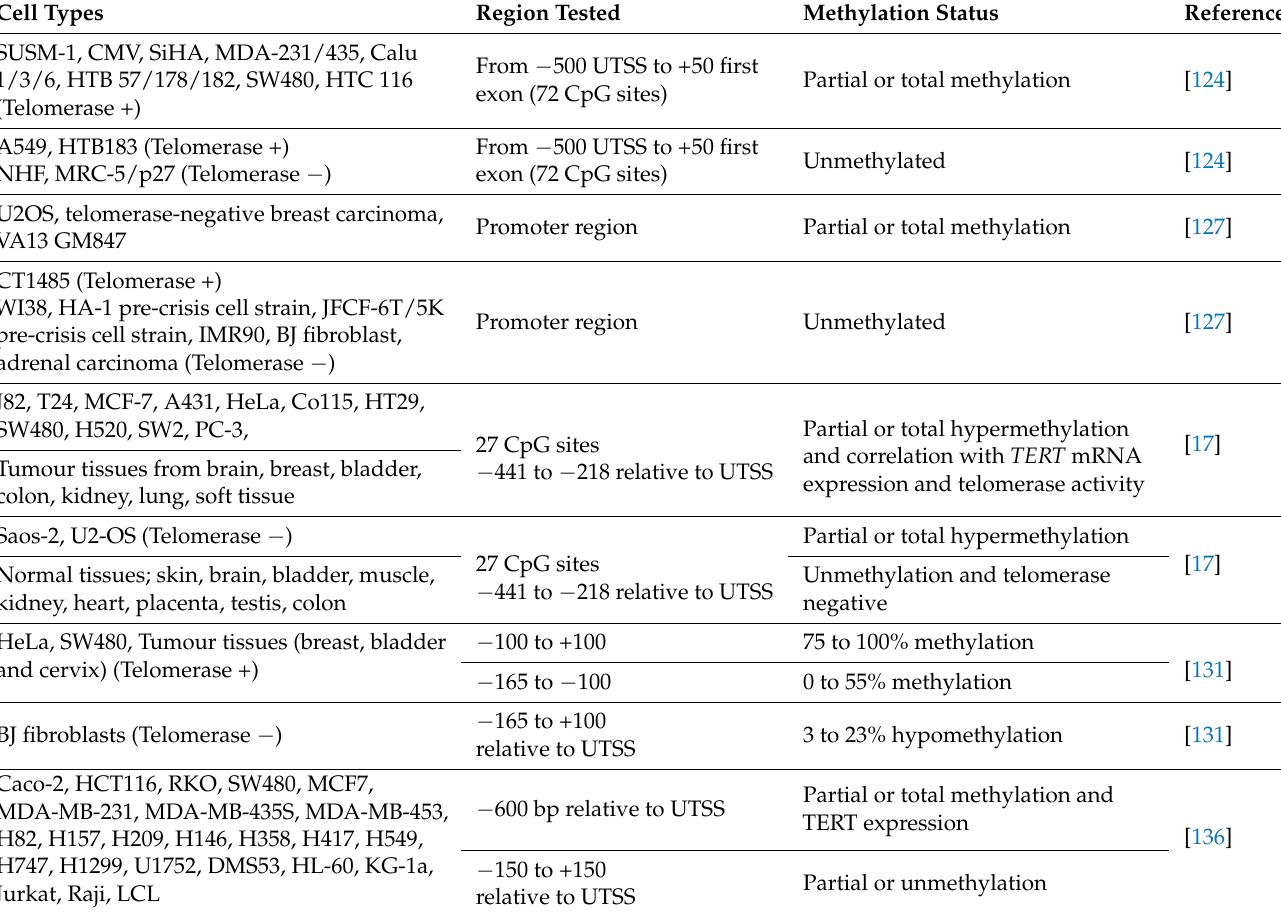
Table 1. Reported methylation status of the TERT promoter